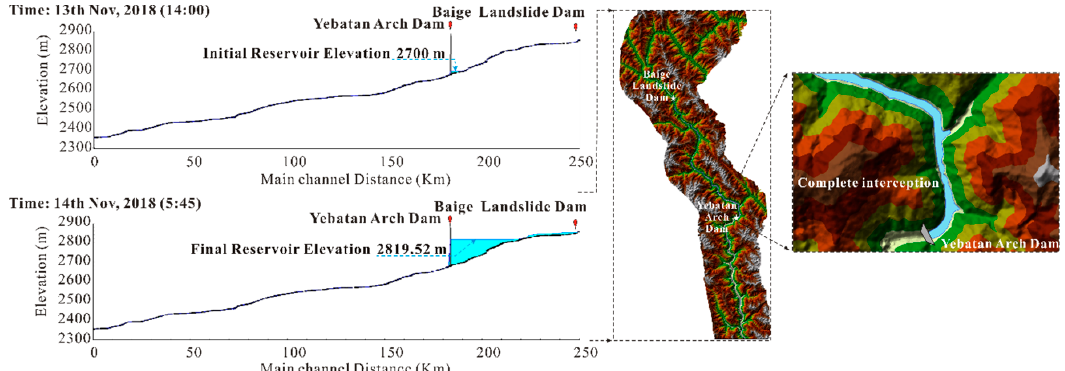
Figure 8. Water surface curve ( left ) and three-dimensional display of maximum inundation area at complete interception ( right ). Table 2. Design of orifice switch parameters of the Yebatan arch dam when the comprehensive flood control of blocking and draining are